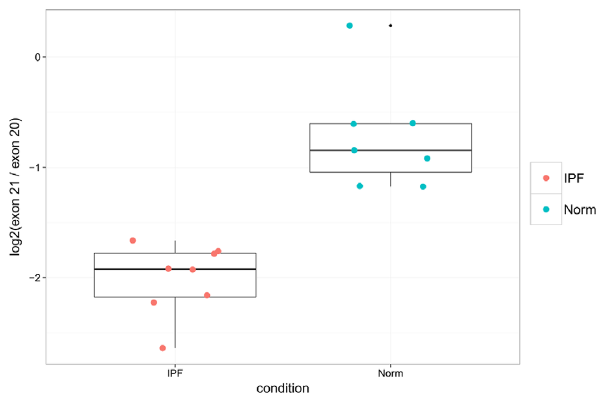
Figure 7. qPCR confirms down-regulation of POSTN exon 21 in IPF lung tissue. Shown are PCR ratios of POSTN exon usage for IPF vs controls (Wilcoxon p-value=3.108e-4).